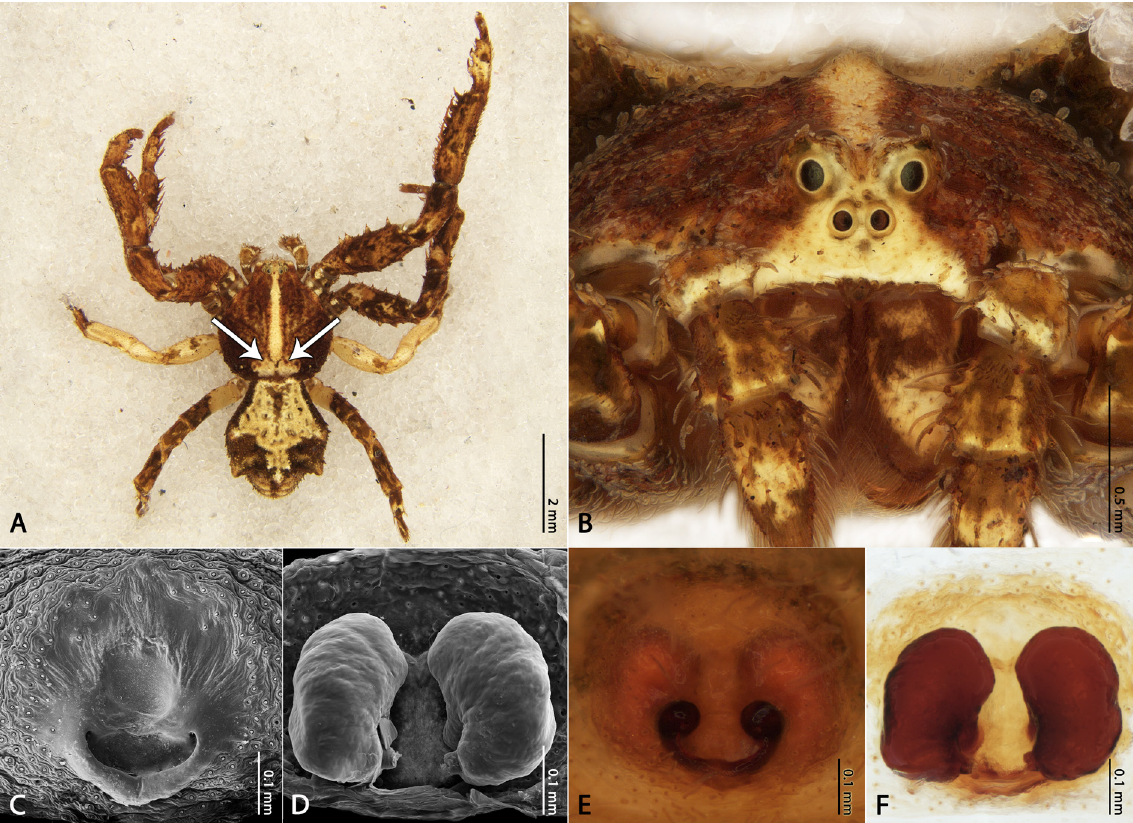
Fig. 4. Female of Kryptochroma hilaris Machado & Teixeira gen. et sp. nov. Holotype (MPEG 13322). A . Habitus, dorsal view (arrows indicate the pair of circular taints on the posterior slope of the prosoma. B . Front. C, E . Epigynal plate, ventral view. D, F . Spermathecae, dorsal